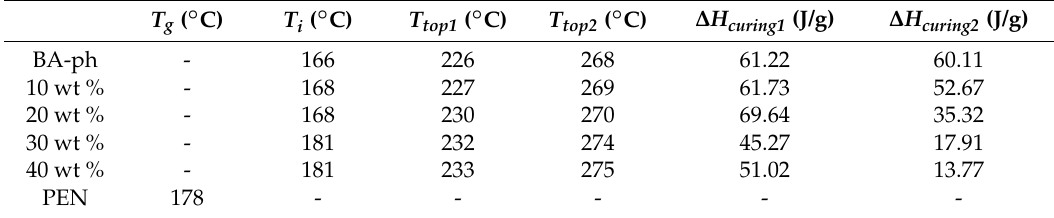
Table 1. Thermal properties of the various BA-ph/PEN